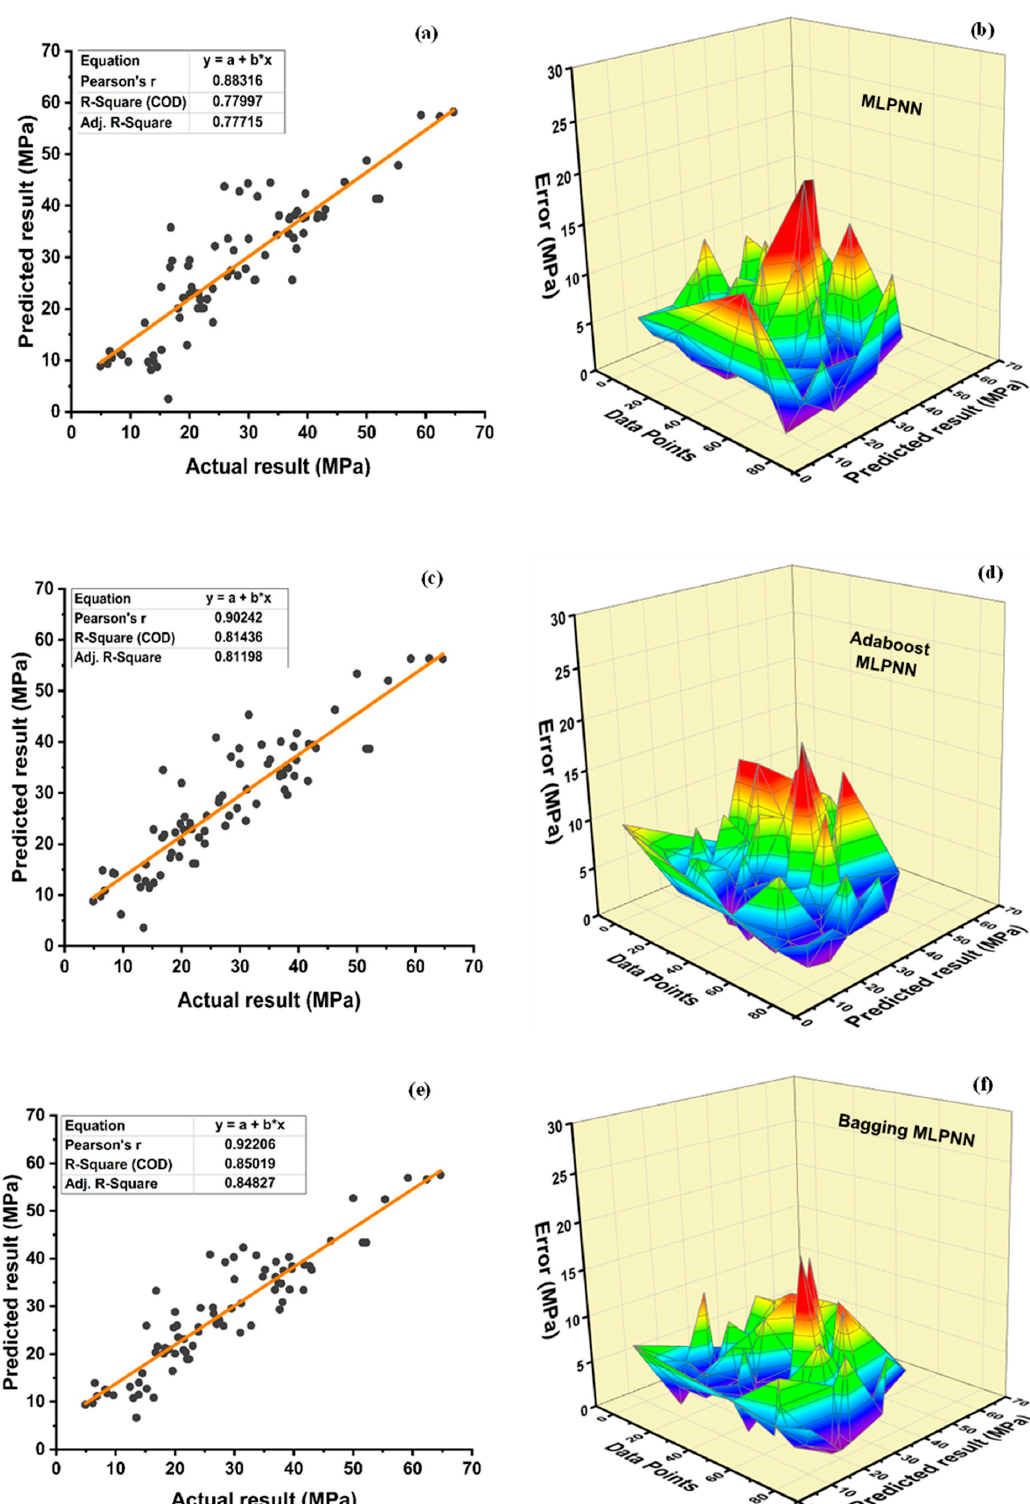
Figure 14. Compressive strength; ( a ) MLPNN regression model; ( b ) MLPNN regression model error distribution; ( c ) MLPNN-Adaboost regression; ( d ) MLPNN-Adaboost regression model er- ror distribution; ( e ) MLPNN-Bagging regression model; ( f ) MLPNN-Bagging regression model error